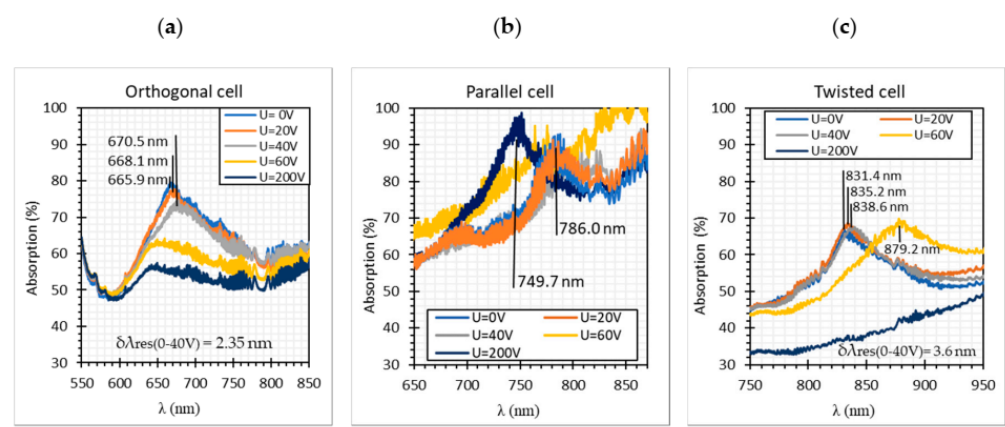
Figure 9. Absorption of SPR dips: ( a ) orthogonal; ( b ) parallel; and ( c ) twisted